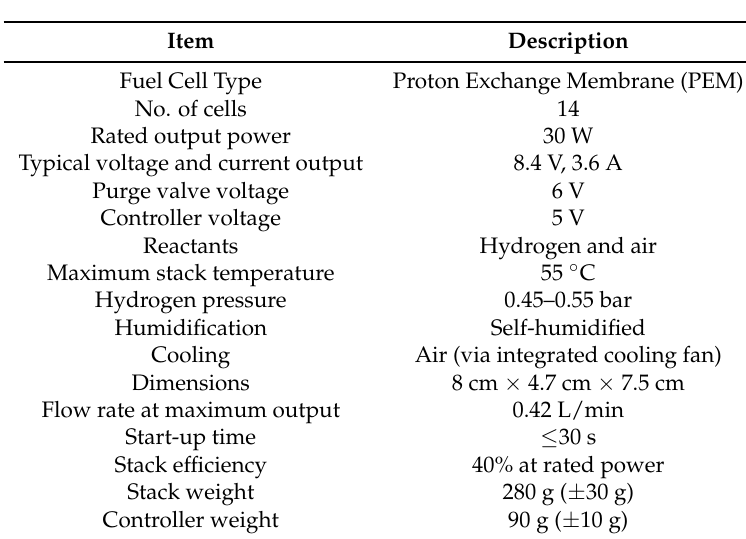
Figure 3. Electrical system schematic with fuel cell stack and supercapacitor. Table 1. H-30 PEM fuel cell